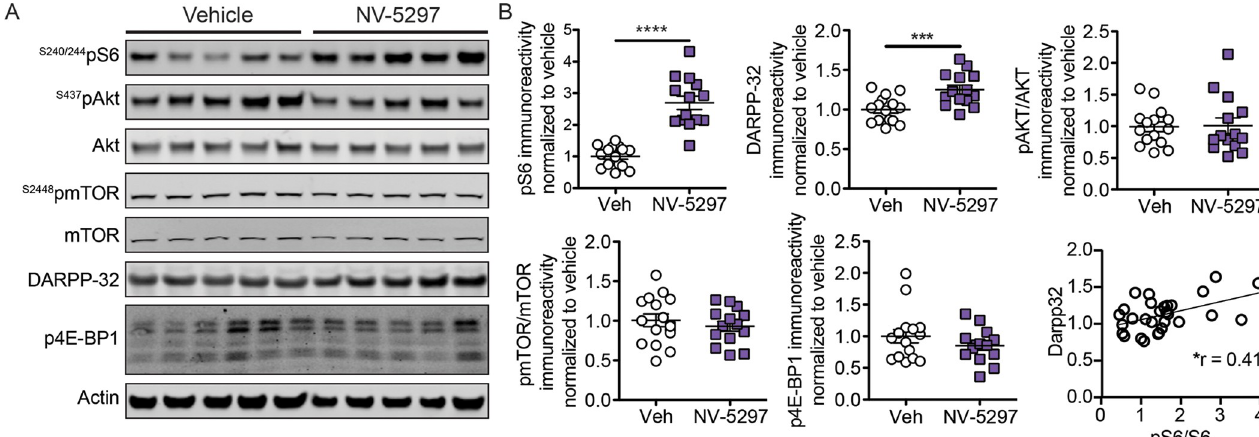
Fig 3. Activation of the mTORC1 pathway in the striatum following daily oral dosing of NV-5297. (A) Representative immunoblots of the striatum for normalized phosphorylated S6 [ S240/244 pS6], S6, phosphorylated Akt [ S437 pAkt], Akt, phosphorylated mTOR [ S2448 pmTOR], mTOR, DARPP-32, phosphorylated 4E-BP1 [ Thr37/46 p4E-BP1], 4E-BP1 and Actin from homogenized striatum isolated from N171-82Q males after 6 weeks of daily oral dosing of NV-5297 (160 mg/kg) or vehicle [Veh]. (B) Quantification of the immunoblots from homogenized striatum isolated 1 hour after the final oral dosing with NV- 5297 (160 mg/kg; n = 14) normalized to loading control levels and further normalized to vehicle treated mice (n = 15). A significant Spearman correlation is present between pS6/S6 and DARPP32 levels. Data are presented as mean ± SEM. � P � 0.05, ��� P � 0.001, ���� P � 0.0001 (one-tailed unpaired Student’s t-test [pmTOR/mTOR, DARPP-32], with a Welch’s correction [pS6/S6, p4E-BP1/4E-BP1], Mann-Whitney test [pAkt/Akt].